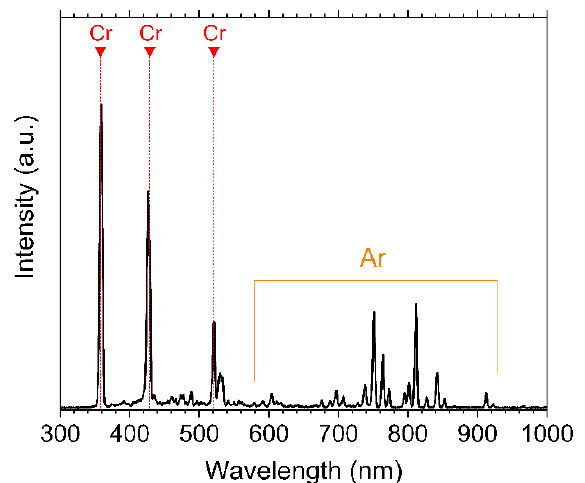
Figure 1. Optical emission spectra of Cr plasma. The most intensive Cr emission and Ar emission lines are indicated.